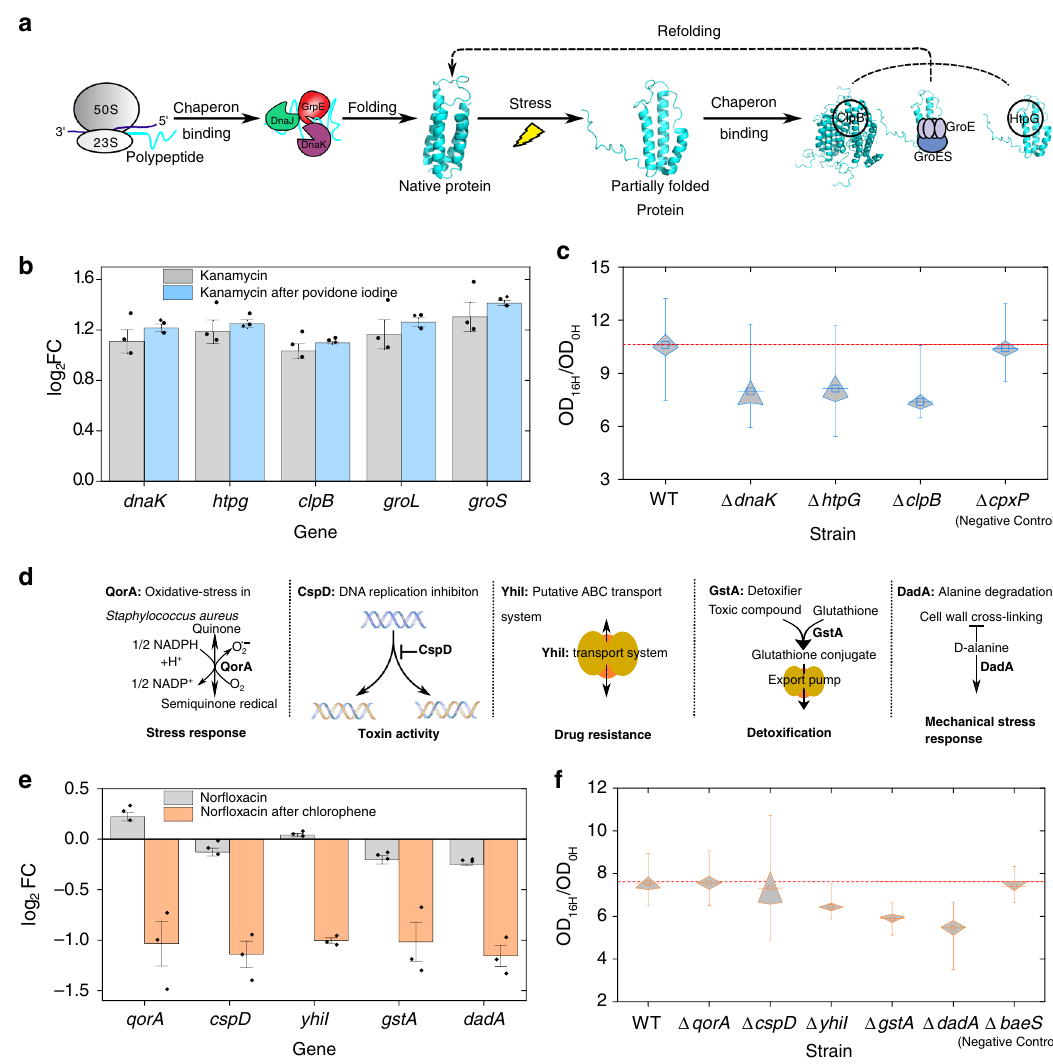
Fig. 5 The genetic basis of cross-stress behavior. a The protein folding pathway and key proteins corresponding to genes that were found to be differentially expressed in the povidone-iodine/kanamycin combination, which exhibits the highest cross-protection across all cases ( fi tness increase of 65.1 ± 10.4%). b All differentially upregulated genes in the povidone-iodine/kanamycin combination, compared to kanamycin only, which have all been identi fi ed as chaperons ( n = 3, biological replicates). c Fitness change of single knockout mutants in kanamycin for each differentially expressed chaperon. The red line denotes the fi tness of WT; Δ dnaK , Δ htpG , Δ clpB are the three differentially upregulated chaperons ( p value of 0.007, 0.02, and 0.001, respectively); Δ cpxP is a non-differentially expressed chaperon used as a negative control ( p value of 0.396, n = 9, biological replicates). d Differentially downregulated stress-related genes with more than twofold change exclusively in the chlorophene/nor fl oxacin combination, which exhibits the highest cross-vulnerability across all cases ( fi tness decreases by 13.4 ± 12.9%). e Expression pro fi les of potential genes involved in cross-vulnerability. ( n = 3, biological replicates). f Fitness change of single knockout mutants, with yhil ( p value = 0.004), gstA ( p value = 0.007), and dadA ( p value = 0.007) knockout mutants having a lower fi tness than WT after nor fl oxacin exposure, supporting the cross-vulnerability due to chlorophene conditioning leading to downregulation. Δ baeS ( p value of 0.479) is a differentially expressed gene, which is involved in adaption to envelope stress, was used as a negative control ( n = 8, biological replicates). Black circles in b and e represent raw data points. Boxes in c and f represent the standard error of the mean (SEM), the middle line represents the mean value, and the whisker line extends to the minimum and maximum values. An error bar represents an SEM. The p values were calculated by the one-sided Wilcoxon rank-sum FeatureCounts 66 , yielding the number of transcripts for each gene in any given biological replicate. The number of transcripts for each gene was then converted to count per million (CPM) after dividing by the library size of the replicate. Finally, the gene CPM values for each replicate were normalized using the means of the corresponding gene CPM values from the control sample replicates. In all fi gures related to the performance of OPEX except Supplementary Figs. 10 – 13, only the genes that have CPM larger than 100 in half of the replicates were used 67 .